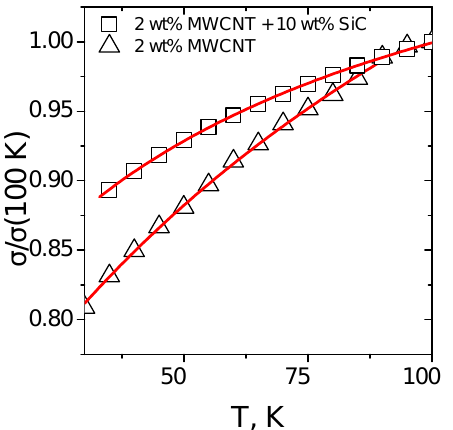
Figure 4. Relative conductivity ( σ / σ (100 K)) dependence on the temperature (symbols); fit with the tunnelling law (solid